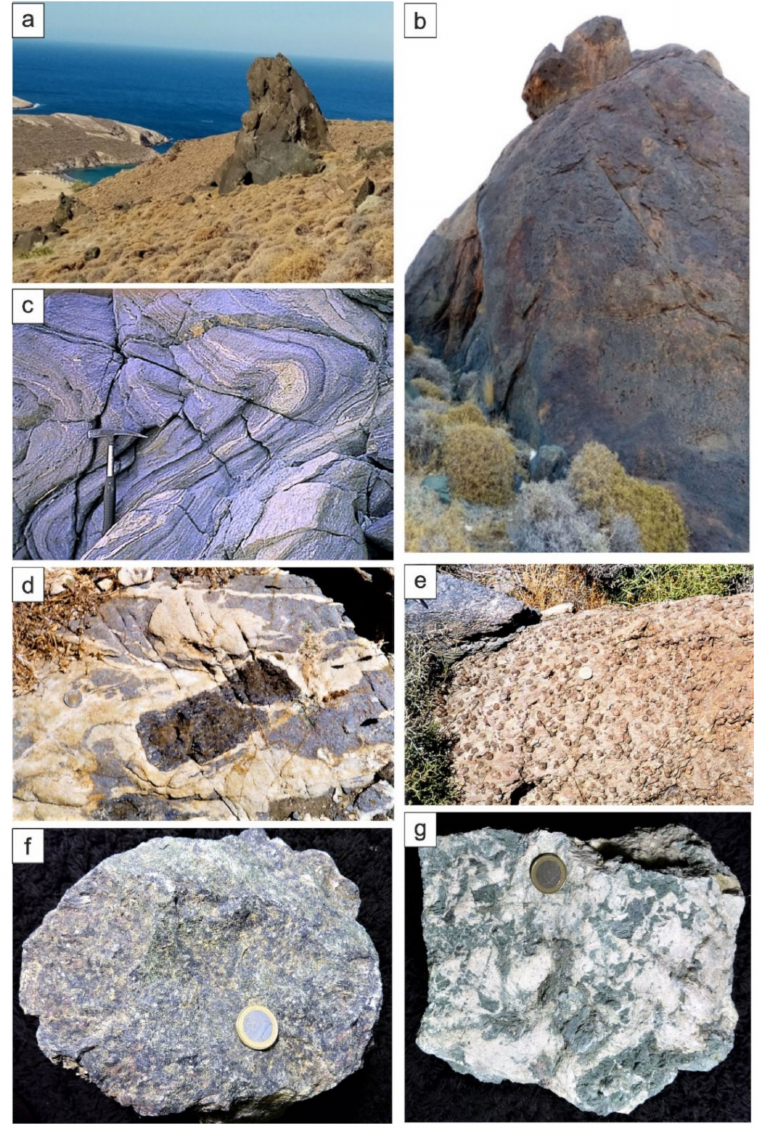
Figure 7. ( a ). Eclogitic monolith locally known as “aerolithos”, from near to Lia Beach, ( b ). Close up of the monolith depicting the blueschist envelope, ( c ). Vivid colored blueschist folded intensely, Airport area, ( d ). Felsic and mafic magma mixing engulfing a rectangular eclogitic fragment, Airport area, ( e ). Fine grained pelite with large garnet porphyroclasts, Kampos, ( f ). Retrograded eclogite from Kini, ( g ). Mg-rich omphacitic metagabbro from